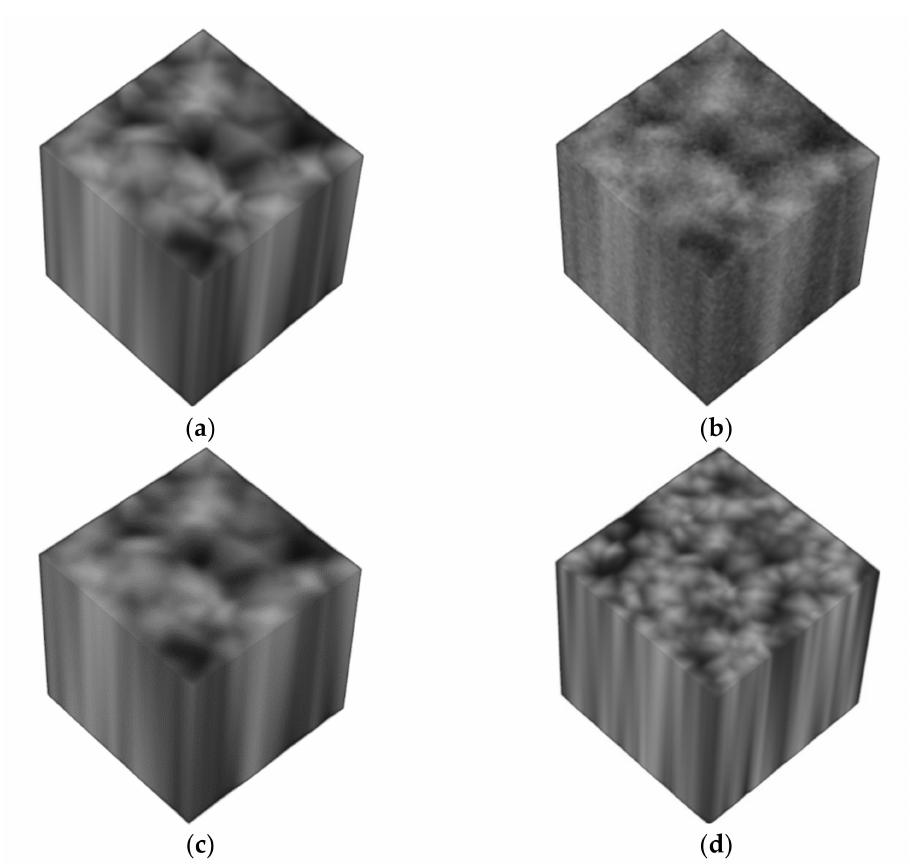
Figure 11. Examples of textures from category Blocks: ( a ) normal ( b ) noisy ( c ) smoothed ( d ) subsampled.